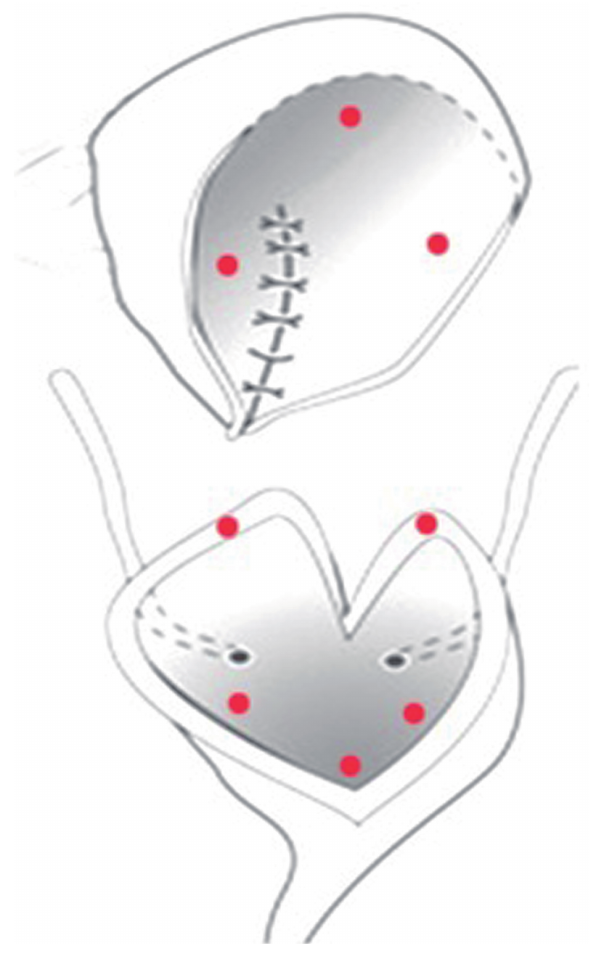
figure 1 - planned sites for biopsies (triangular